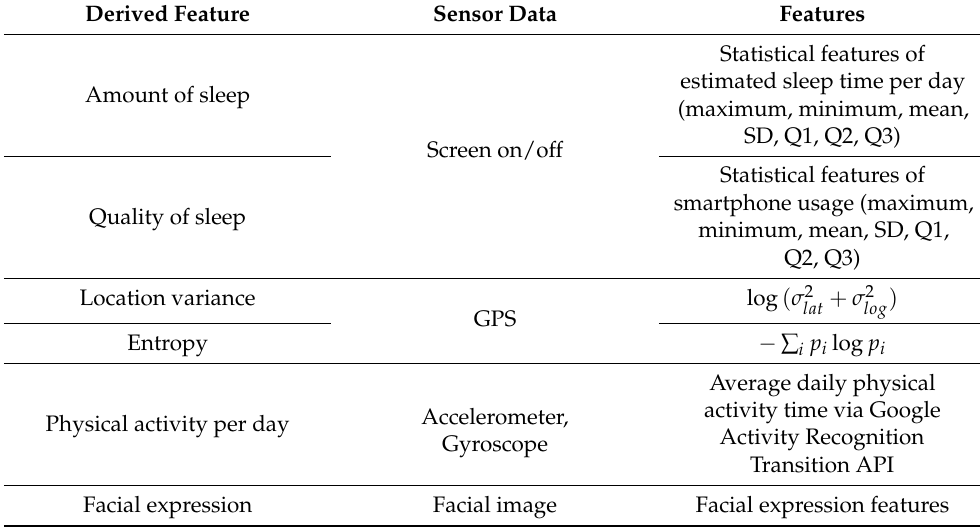
Table 3. Multimodal Derived Features. We present multimodal derived features for predicting depression in participants. For the proposed derived features, screen on/off, GPS, accelerometer, gyroscope, and facial image are utilized. Consequently, 33 features are designed to predict